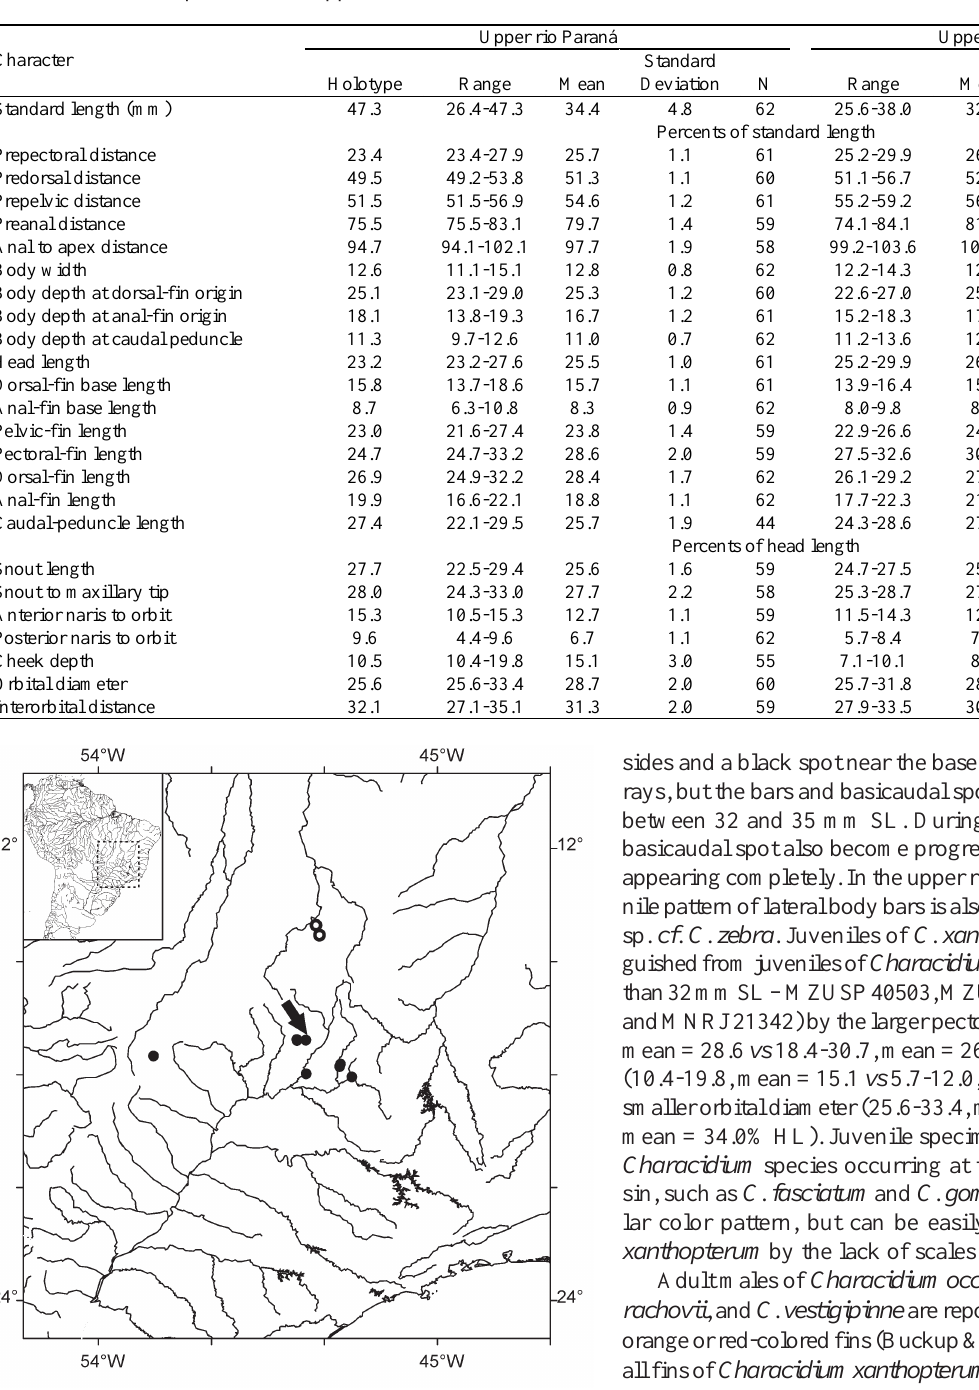
Table 1. Morphometric data of Characidium xanthopterum samples from the upper rio Paraná basin based on DZSJRP 6491 (n=3), DZSJRP 6508 (n=1), DZSJRP 6853 (n=2), DZSJRP 6980 (n=6), DZSJRP 7041 (n=1), DZSJRP 7060 (n=4), DZSJRP 10474 (holotype), DZSJRP 10797 (n=1), MNRJ 11481 (n=17), MNRJ 19729 (n=1), MNRJ 19842 (n=2), MNRJ 20256 (n=5), MNRJ 20257 (n=6), and NUP 4414 (n=15) and samples from the upper rio Tocantins basin based on MNRJ 11431 (n=18). N is number of